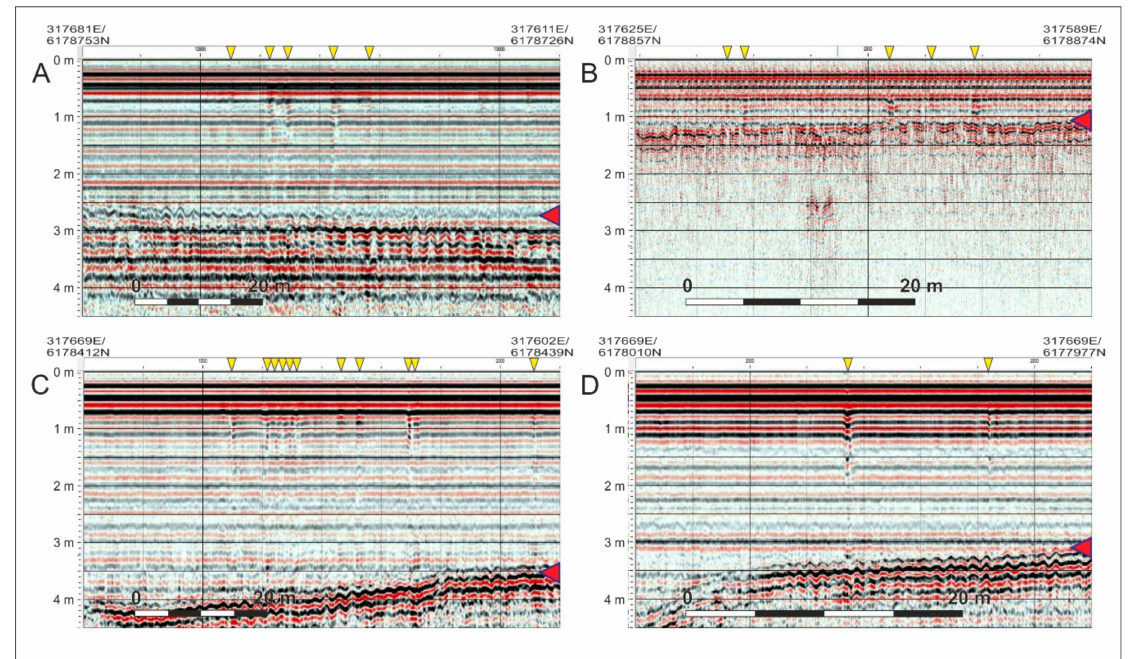
Figure 14. Profiles ( A , B ): acoustic responses from site 1, the Blak site (401257-3). Profile ( C ): acoustic responses from site 2 (401257-56). Profile ( D ): acoustic responses from site 3 (401257-57). The seafloor is marked with a red arrow at the right side of the profiles and acoustic responses with yellow arrows from above. Depth is shown at the left side. The horizontal scale of the profiles varies with the speed at which they were recorded. Zone 33 UTM coordinates. Graphics: